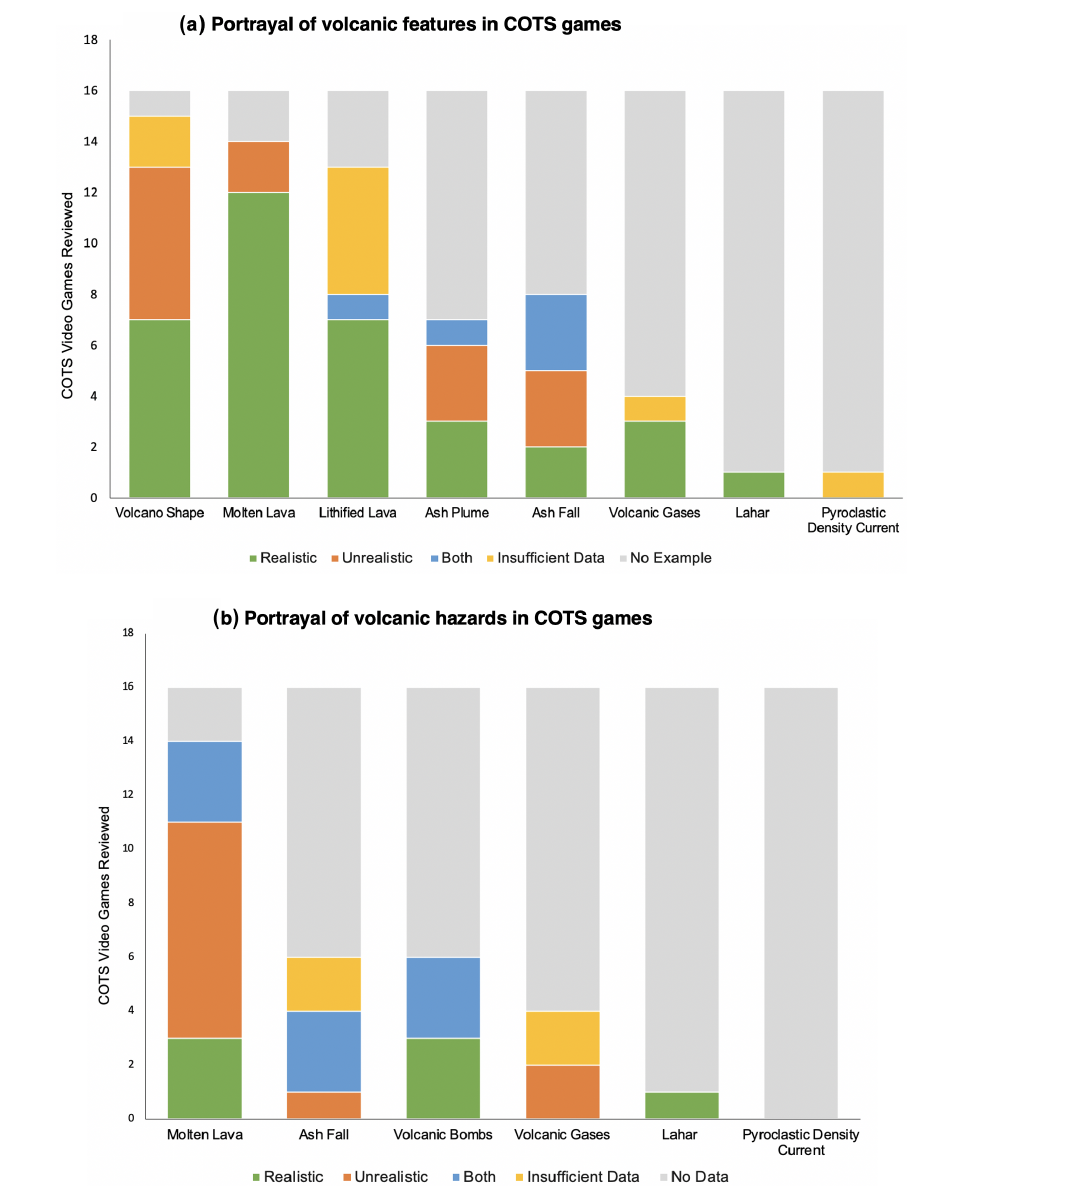
Figure 10. The count of volcanic features (a) and of volcanic hazards (b) found within the COTS video games reviewed, displaying whether or not they were portrayed in a realistic or unrealistic